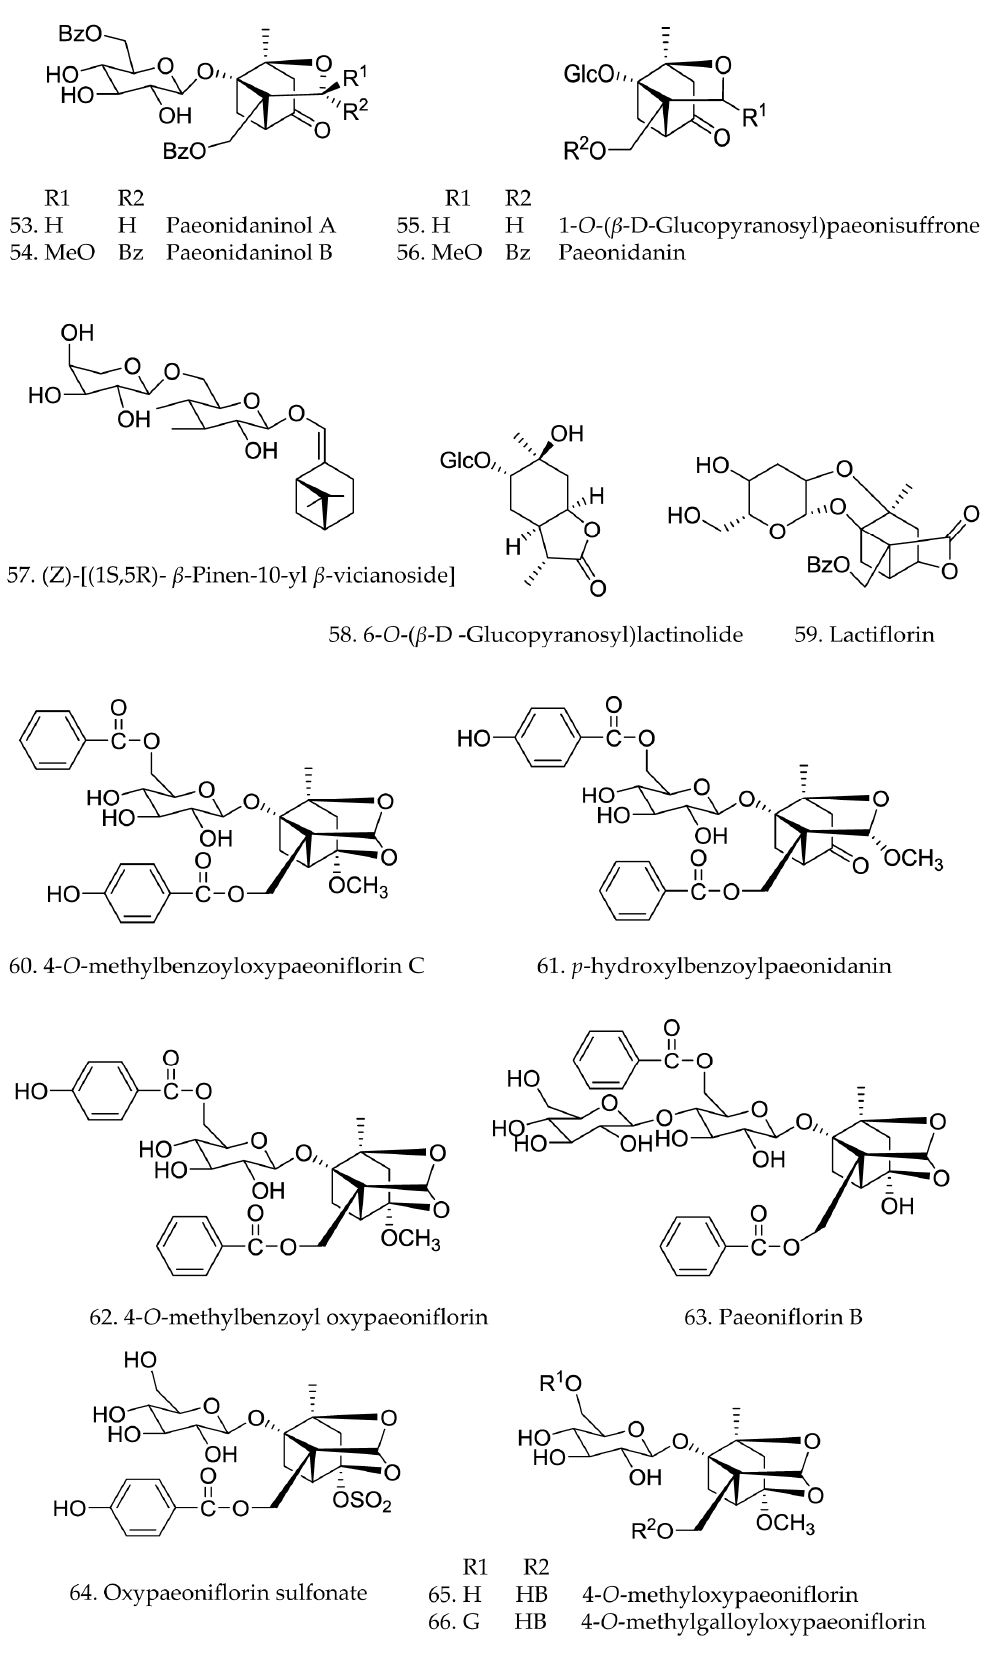
Figure 3 . Cont . Figure 3. Cont